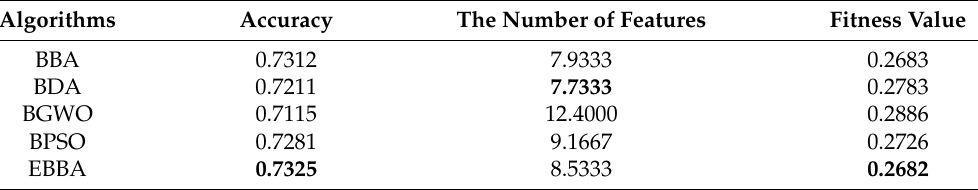
Table 5. Optimization results obtained by different algorithms under decision tree. (The best values are highlighted in bold).